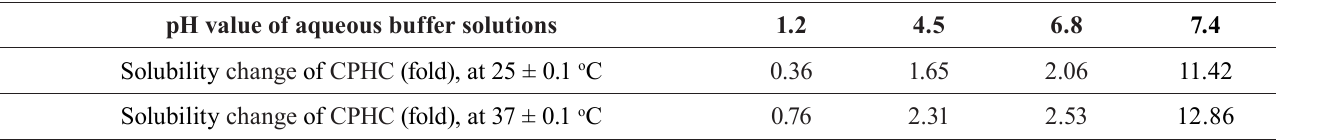
TABLE I - I nfluence of pH values on solubility of CPHC at 25 ± 0.1 o C and at 37 ± 0.1 o C pH value of aqueous buffer